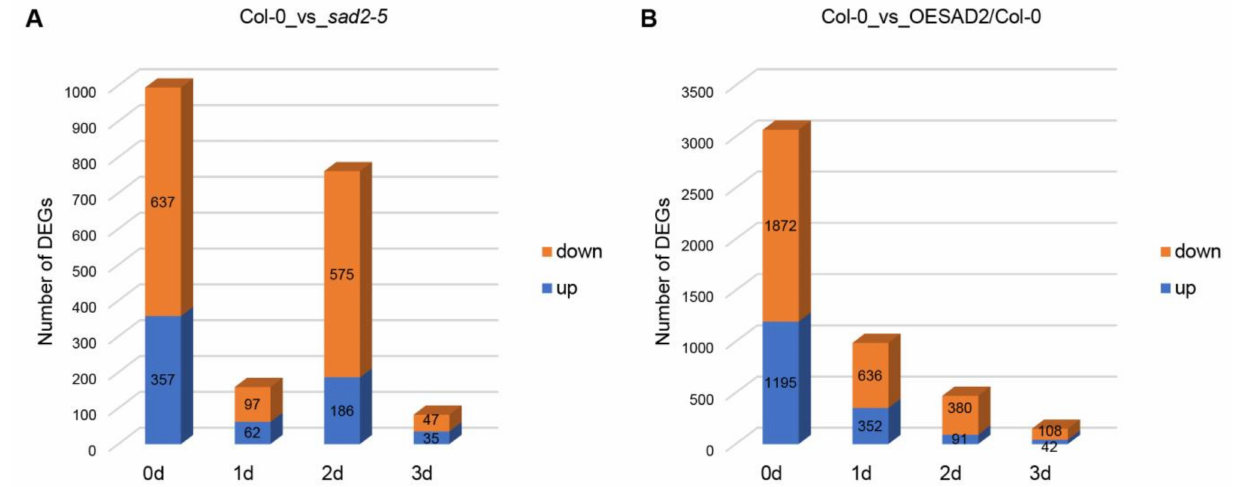
Figure 2. Differentially expressed genes (DEGs) in SAD2 knockout and overexpression lines ( sad2-5 and OESAD2/Col-0, respectively) compared to Col-0. ( A ) DEGs between sad2-5 and Col-0 at multiple time points after inoculation with Pseudomonas syringae pv. tomato ( Pst ) DC3000. ( B ) DEGs between OESAD2/Col-0 and Col-0 at multiple time points after inoculation with Pst DC3000. “d” here indicates days post-inoculation with Pst